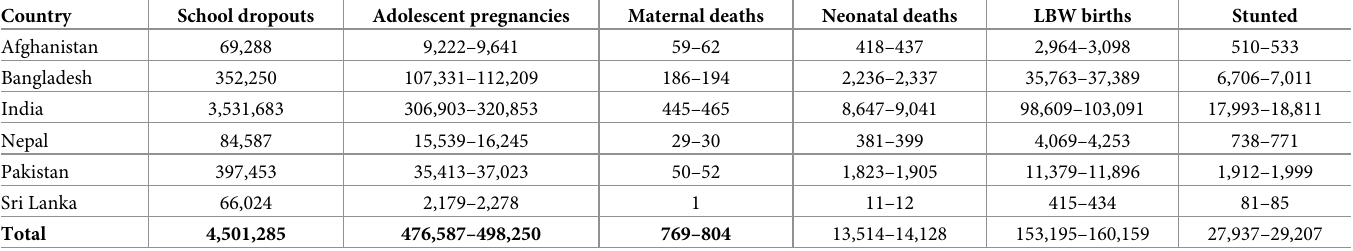
Table 3. Estimated number of additional adolescent pregnancies, maternal and neonatal deaths, low birthweight births and stunted children resulting from girls dropping out of school due to the COVID-19 pandemic in six South Asian countries.